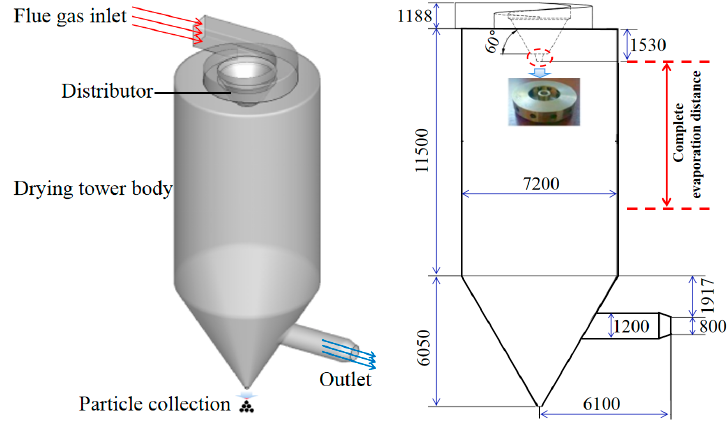
Figure 2. Schematic diagram of spray drying tower without deflectors. Table 1. Physical parameters of flue gas in actual operation under full load. Item